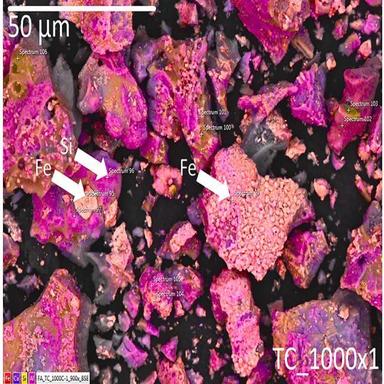
BSE image with elemental mapping of FA TC cycled to 1000◦Cx1. Rough nodules are iron rich, and silicon rich areas appear smooth. 900x magnification.